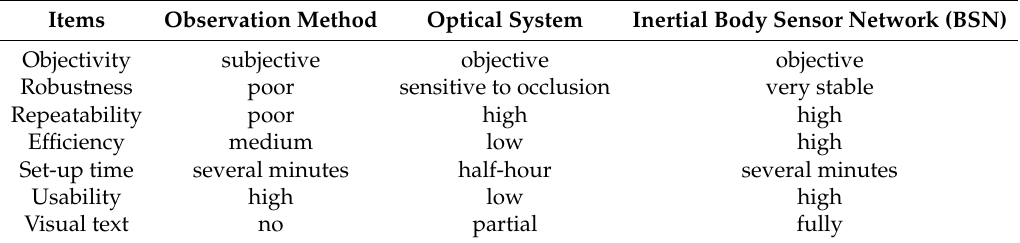
Table 2. Comparison of mainstream gait analysis